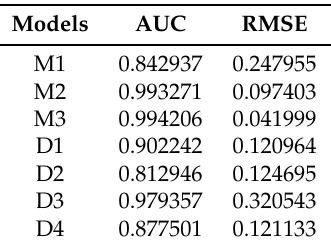
Table 1. Models’ performances on the validation dataset with 181 variables using AUC and RMSE values for the seven models.